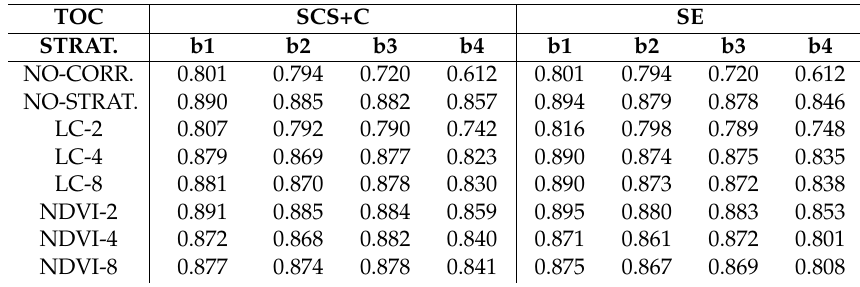
Table 4. MSSIM of the different stratification approaches for each band. Ranks from 0 (worst) to 1 (best). TOC SCS+C SE TOC STRAT.